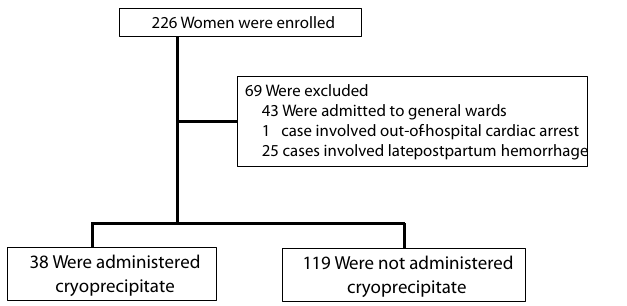
Figure 1. Flowchart of participant enrolment in the